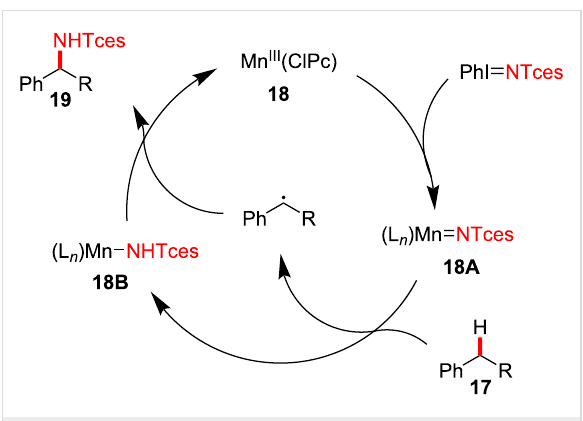
Figure 6: Proposed mechanism of manganese-catalyzed C–H amina-